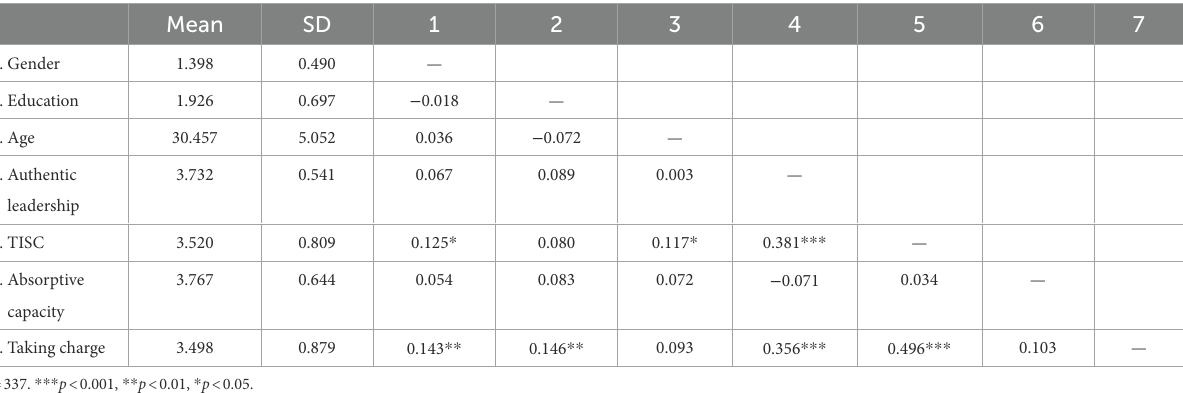
TABLE 2 Descriptive statistics and correlation coefficients.